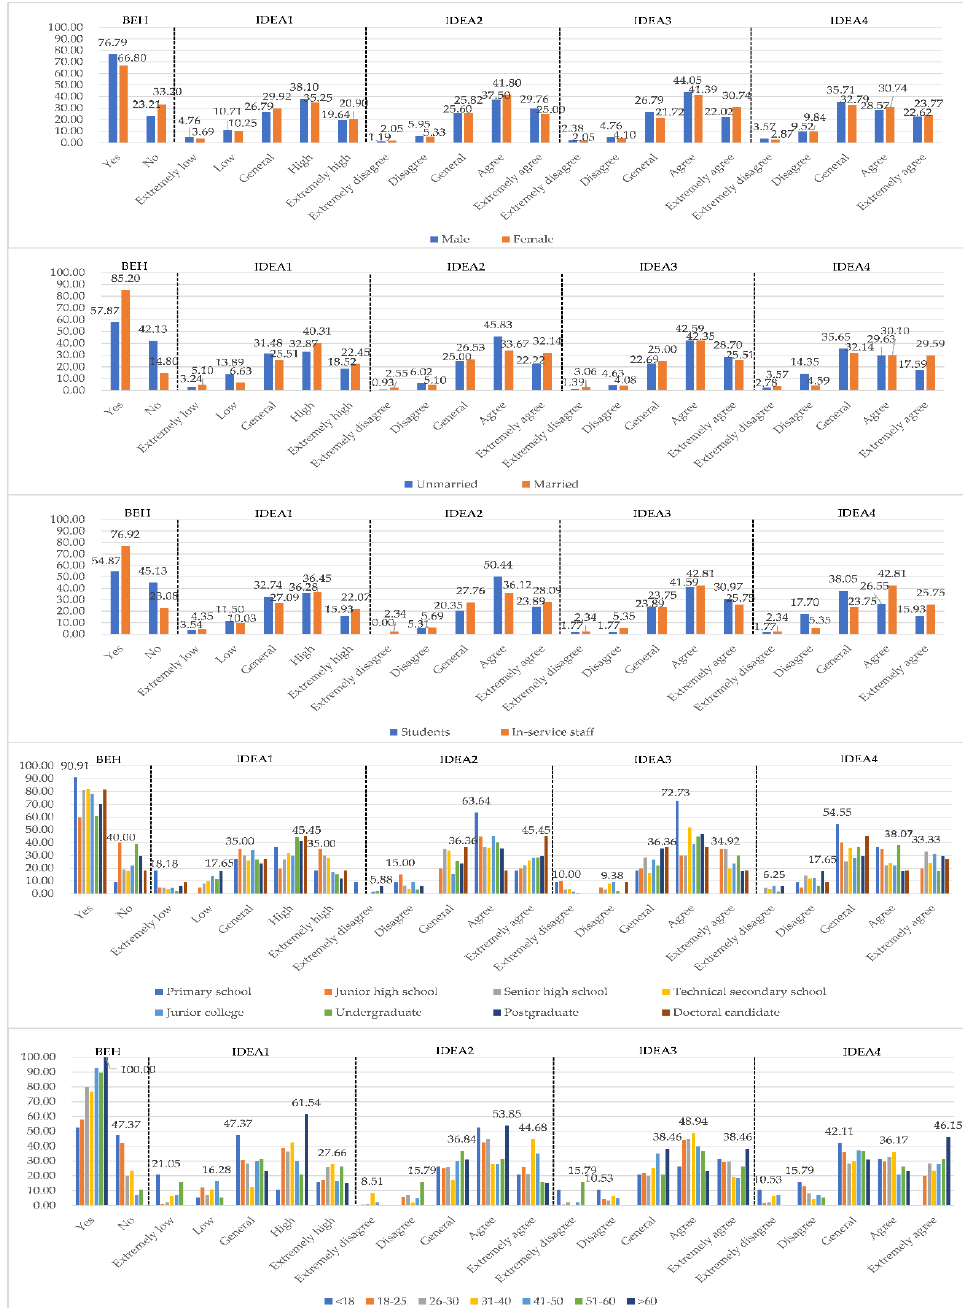
Figure 3. Group description. Note 1. BEH = Go out to rural tourism to relax in the last month; IDEA1 = Willingness to go out; IDEA2 = Willingness to choose a place close to home; IDEA3 = Traveling in countryside can relax the mind; IDEA4 = Rural tourism is safer. Note 2. The unit of data in the figure was “%”. Note 3. In the group description of education and age, the data label was indicated by the maximum value of that option.